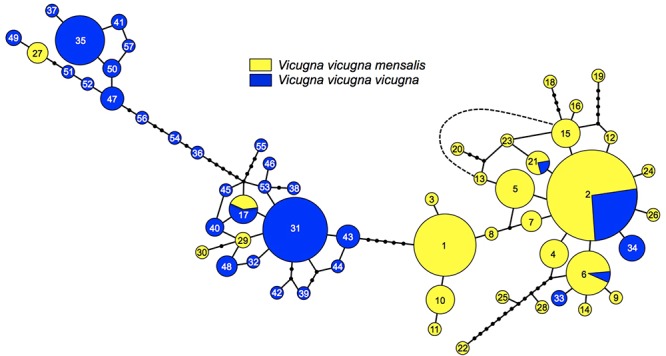
Minimum spanning network representing the relationships among 57 control region haplotypes, numbers represent each haplotype (see Supplementary Table 2). Circle sizes correspond to haplotype frequencies. Branches without circles correspond to one difference between haplotypes, and each small black circle corresponds to one additional mutation. Dashed line represents one mutational step between haplotypes 13 and 16.